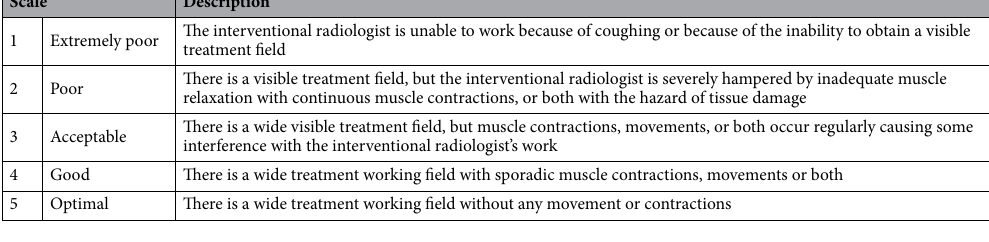
Table 1. The L-SRS rating scale 15